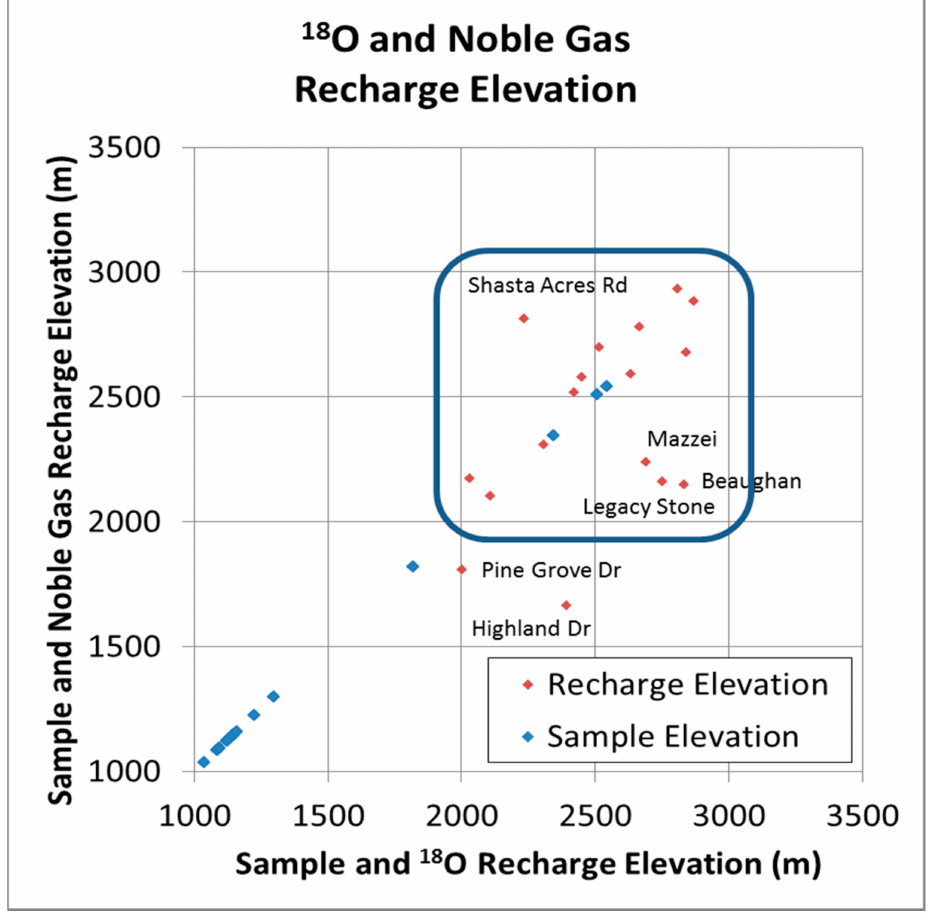
Figure 10. Recharge elevation, determined independently from δ 18 O and noble gas recharge temperature, show good agreement. (Labeled samples are called out in the text.) The box encloses the recharge elevation range used in the spatial